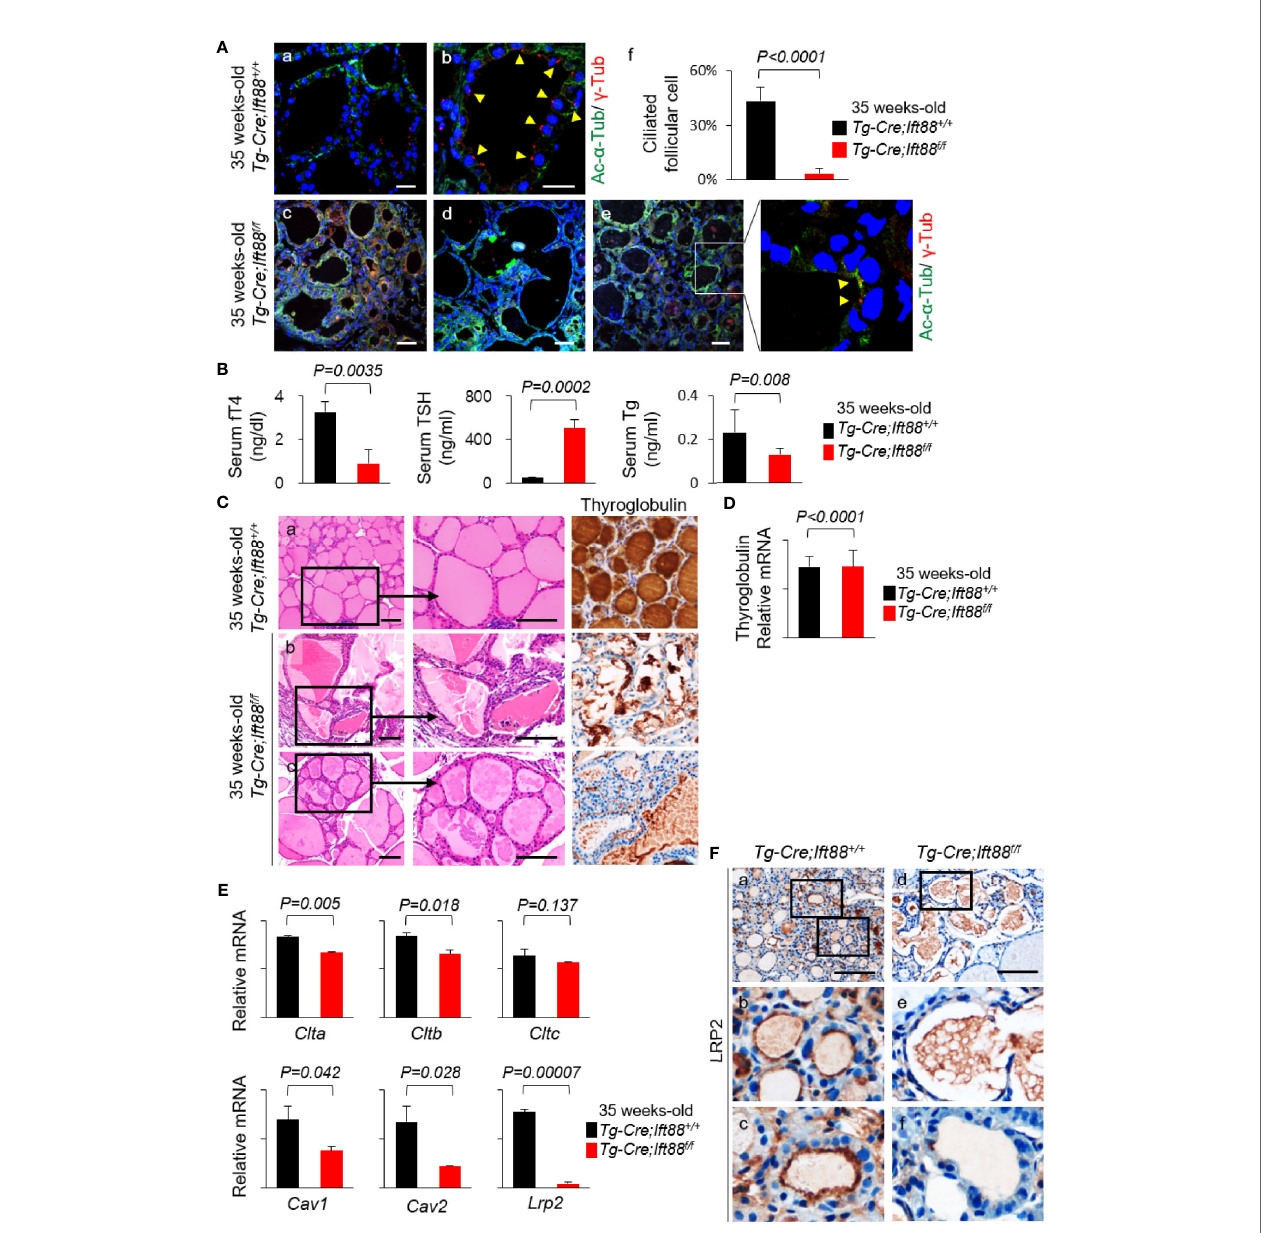
FIGURE 4 | LRP2 expression of murine thyroid follicles regulated by ciliogenesis. (A) Immuno fl uorescence analysis of primary cilia with acetylated a -tubulin (green) to detect the axoneme and g -tubulin (red) to detect the basal body. Scale bar, 20 m m. Frequency of thyroid follicles containing primary cilia was 3.31 ± 3.00% in the Tg-Cre;Ift88 fl ox/ fl ox mice and 43.32 ± 7.72% in the Tg-Cre;Ift88 +/+ control mice. In the thyroid follicles of Tg-Cre;Ift88 fl ox/ fl ox mice, primary cilia were rarely detected ( P < 0.0001). Arrowhead indicates primary cilia. (B) Serum fT4 levels were lower in 35-week-old Tg-Cre;Ift88 fl ox/ fl ox mice (0.89 ± 0.65 ng/dL) than in 35-week-old Tg- Cre;Ift88 +/+ control mice (3.25 ± 0.46 ng/dL, P = 0.0035). Serum TSH levels were signi fi cantly higher in 35-week-old Tg-Cre;Ift88 fl ox/ fl ox mice (505.31 ± 75.69 ng/mL) than in 35-week-old Tg-Cre;Ift88 +/+ mice (53.51 ± 3.25 ng/mL, P = 0.0002). Serum Tg levels were signi fi cantly lower in 35-week-old Tg-Cre;Ift88 fl ox/ fl ox mice (0.128 ± 0.026 ng/mL) than in 35-week-old Tg-Cre;Ift88 +/+ mice (0.230 ± 0.105 ng/mL, P = 0.008). (C) Thirty- fi ve-week-old Tg-Cre;Ift88 fl ox/ fl ox thyroid had irregularly dilated follicles with colloidal Tg-negative lumens. Scale bar, 25 m m. (D) There was no difference in thyroid Tg mRNA levels between Tg-Cre;Ift88 fl ox/ fl ox and Tg-Cre;Ift88 +/+ mice ( Tg-Cre;Ift88 fl ox/ fl ox = 14.623 ± 3.327; Tg-Cre;Ift88 +/+ = 14.587 ± 2.141; P < 0.0001). (E) mRNA levels of receptor-mediated Tg endocytosis-related genes Clta , Cltb , Cltc , and Lrp2 were reduced in 35-week-old Tg-Cre;Ift88 fl ox/ fl ox thyroid with ciliary loss. mRNA levels of genes associated with caveolae-mediated endocytosis were lower in 35-week-old Tg-Cre;Ift88 fl ox/ fl ox thyroid than in Tg-Cre;Ift88 +/+ control thyroid ( Cav1 , P =0.042; Cav2 , P =0.028). (F) Immunohistochemical staining of LRP2 was present on the apical plasma membrane of control thyroid follicles, whereas LRP2 was expressed at lower levels in thyroid follicles of 35-week-old Tg-Cre; Ift88 fl ox/ fl ox mice. Scale bar, 25 m